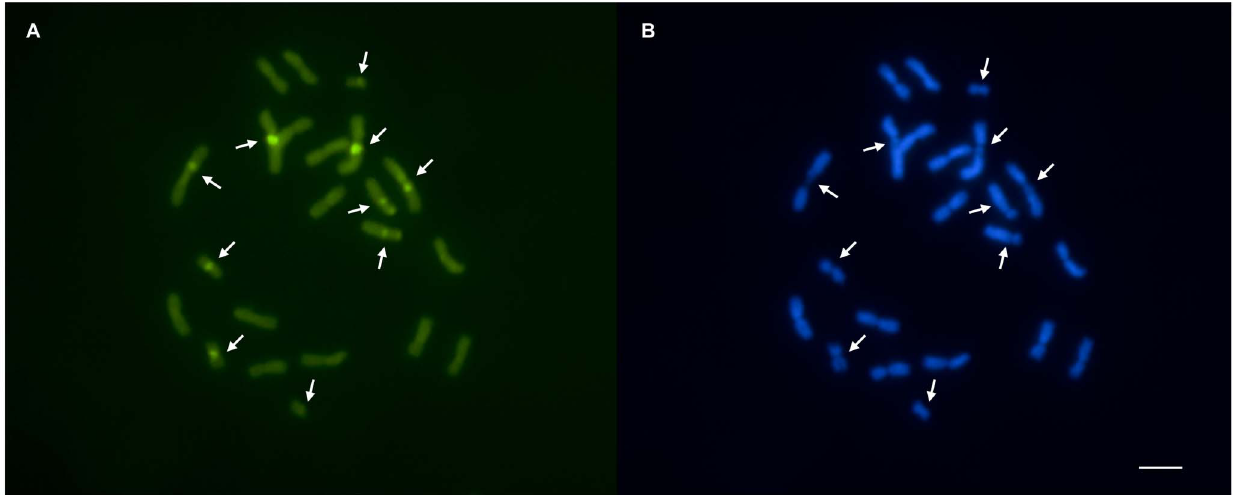
Figure 3. Acromyrmexstriatus metaphase stained with fluorochromes: (A) CMA 3 and (B) DAPI. Positive GC-rich blocks were observed in five chromosome pairs (arrows), which matched the negative AT-rich regions in (B) indicated by arrows. Scale bar=5 m m.